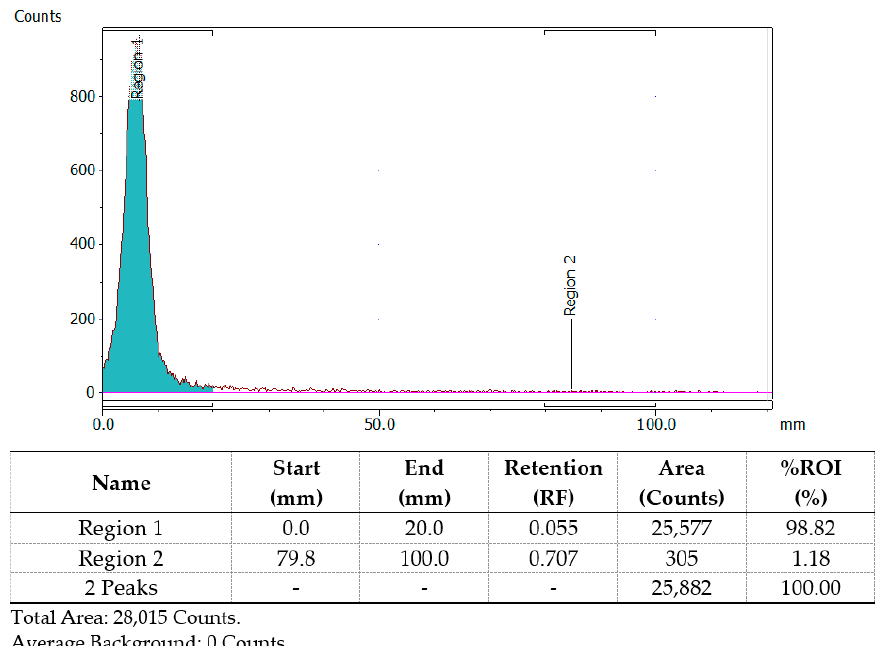
Figure 2. Representative radio-TLC chromatograph of [ 68 Ga]Ga-MA or [ 68 Ga]Ga-MAPEG obtained after 30 min of incubation at 75 °C.